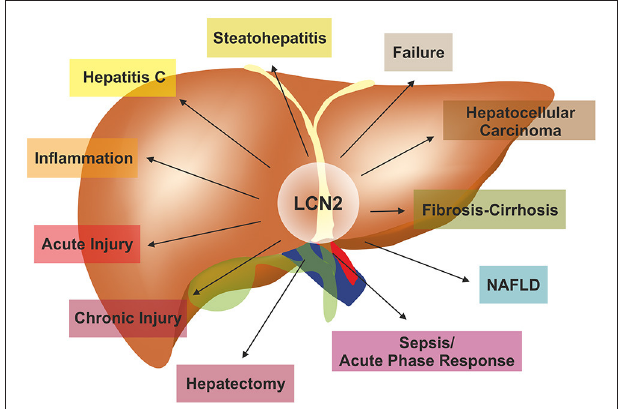
FIGURE 3 | LCN2 in the pathogenesis of liver diseases. LCN2 is a versatile adiponectin that influences all kinds of liver diseases. For more details on experimental and clinical findings associated with altered LCN2 expression refer to Table 3